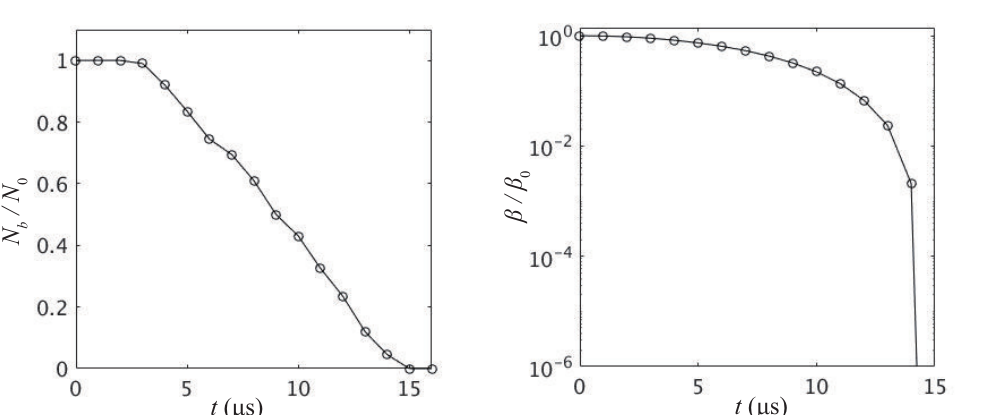
Figure 15. The time history of the non-dimensional active bubble number N b / N 0 ( N 0 = 200) and the averaged gas fraction β / β 0 , here being β = Σ V